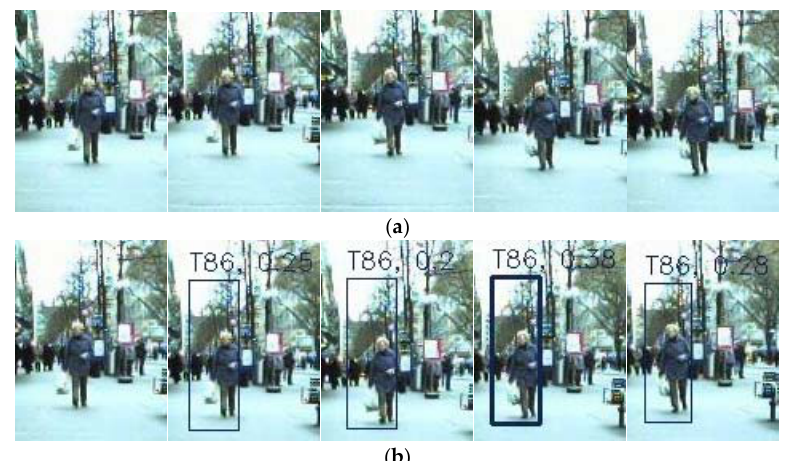
Figure 6. Comparison of the tracking results between RJMCMC and the proposed method with ETH-Bahnhof. ( a ) Detection results and tracking results of the RJMCMC method; ( b ) Detection and tracking results of the proposed method.